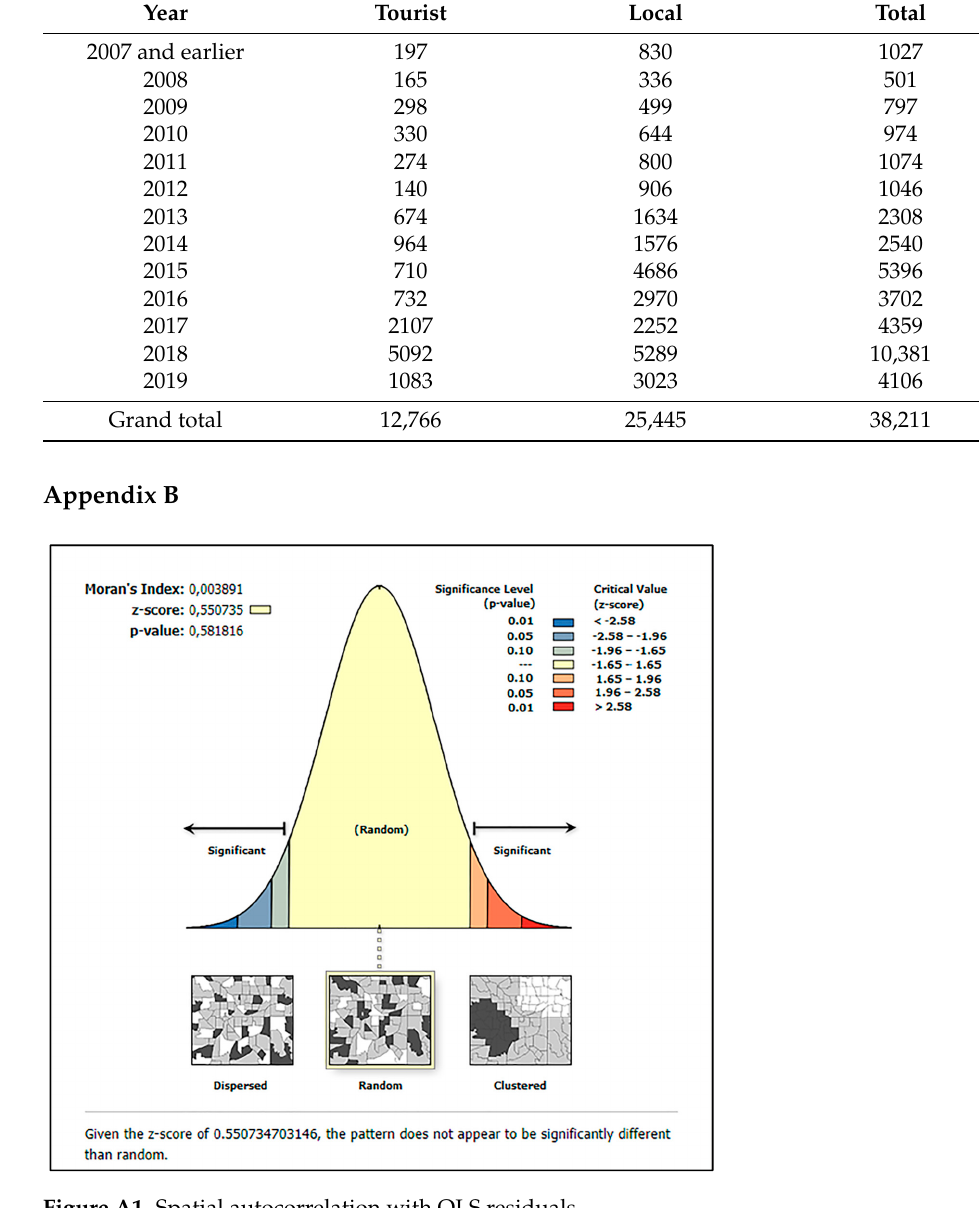
Figure A1. Spatial autocorrelation with OLS residuals. Table A3. Diagnostic information of OLS.